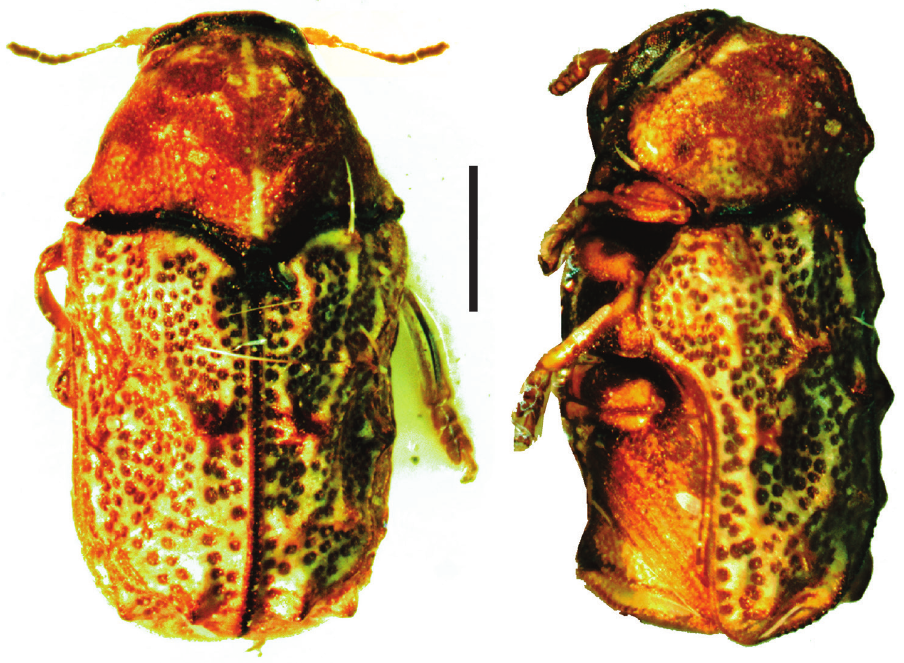
Figure 29. Chlamisus apricarius (Lacordaire) (3) , left: habitus (dorsal view), right: habitus (lateral